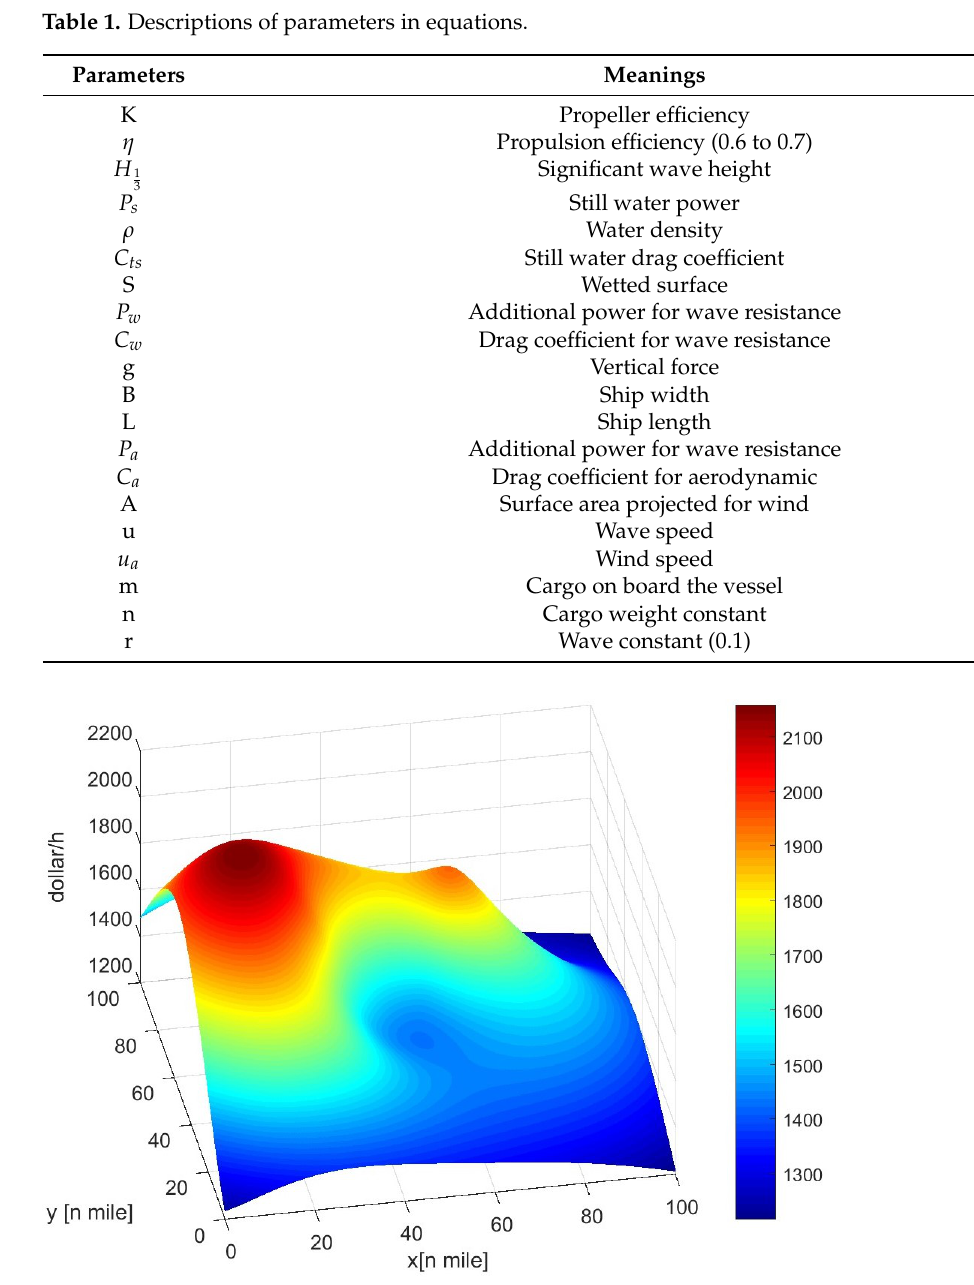
Figure 2. Three-dimensional cost